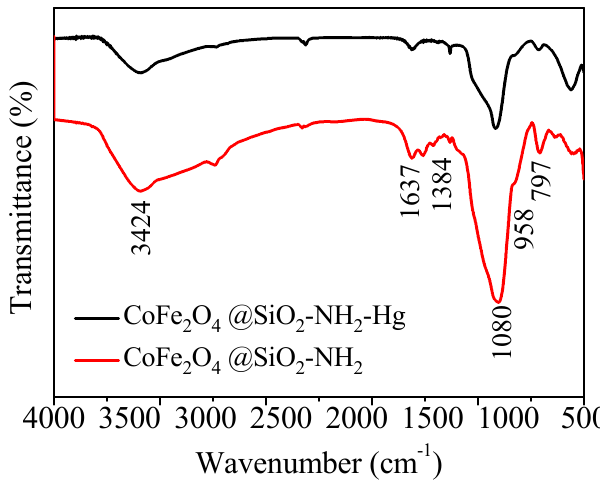
Figure 15. FTIR spectra of CoFe 2 O 4 @SiO 2 –NH 2 before and after adsorption.